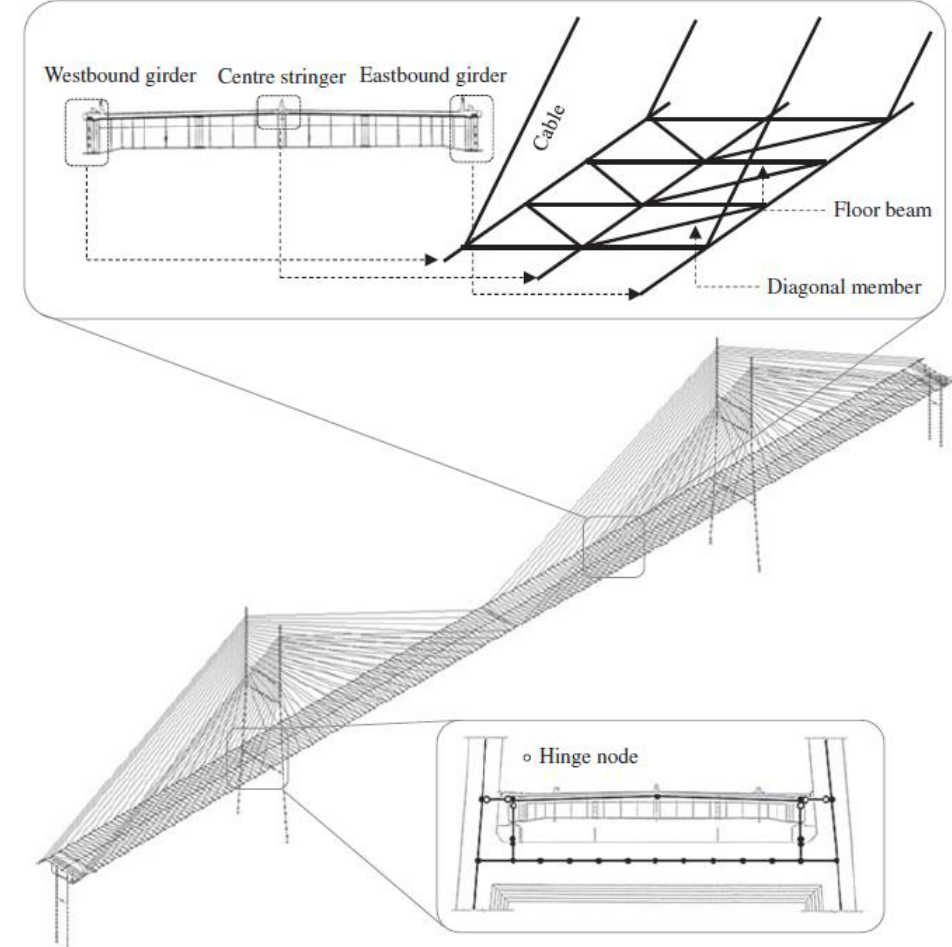
Figure 8. Triple-girder FE model of Seohae Bridge [98].